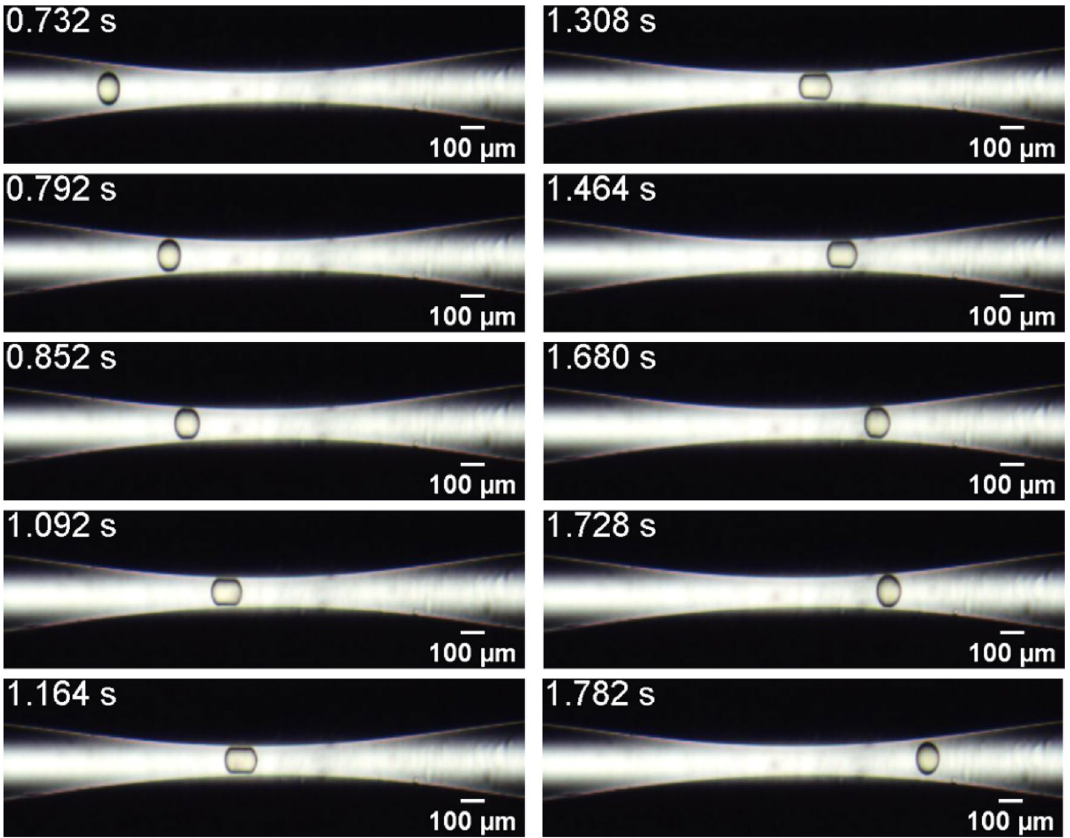
Figure 3. Evolution of the microcapsule position and configuration as it flows through the constriction. System #5, D = 109.1 μm and h = 5.3 μm ( a = 1.09 and Ca s = 1.7 × 10